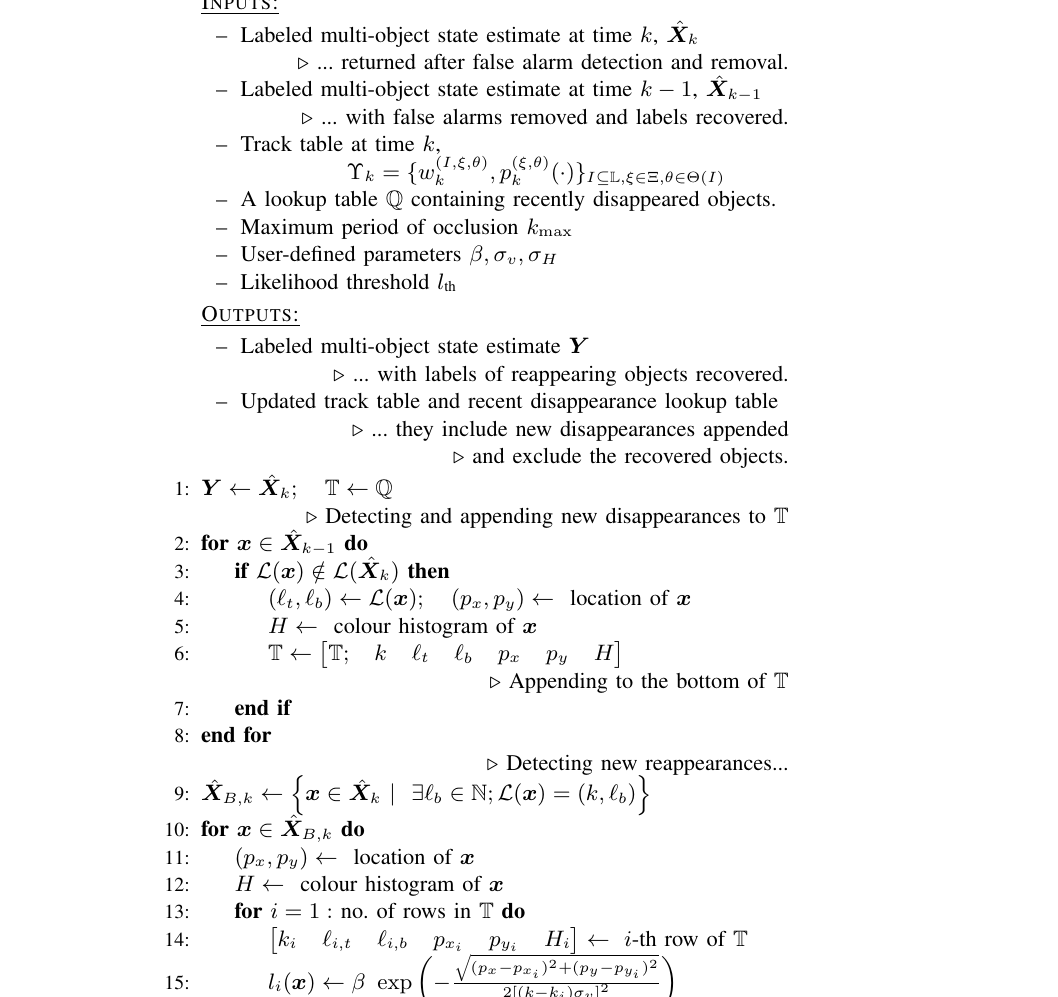
Algorithm 2 Pseudocode for the proposed label recovery algorithm. I NPUTS